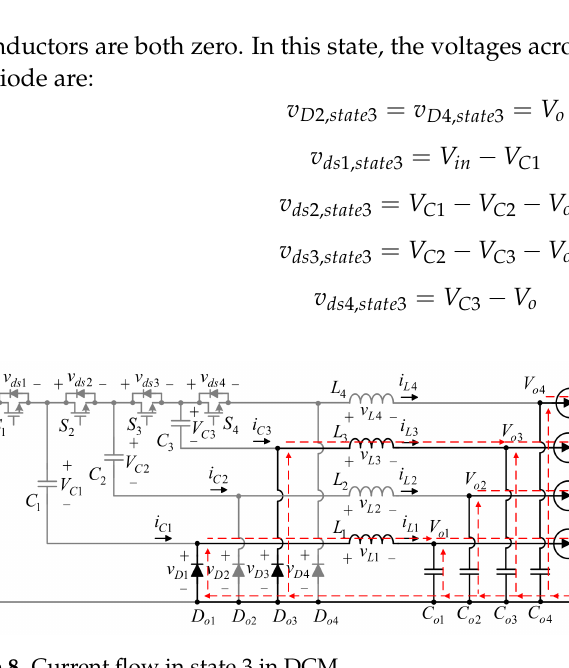
Figure 8. Current flow in state 3 in DCM.